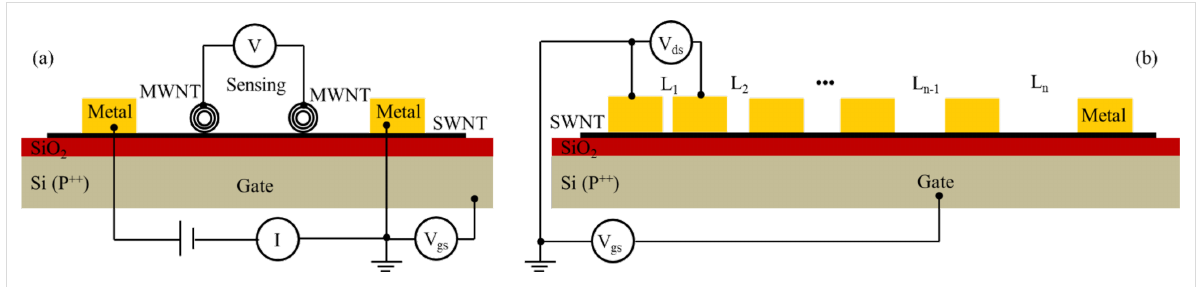
Figure 5: Schematics of different approaches for characterizing the electrical contacts of CNFETs. a) An optimized configuration for the four-terminal measurement by using MWCNTs as the voltage sensing electrode according to the reference [26]. b) Multiple contacts are defined on the same indi- vidual SWCNT with different channel lengths. Potential drops can be measured between any two